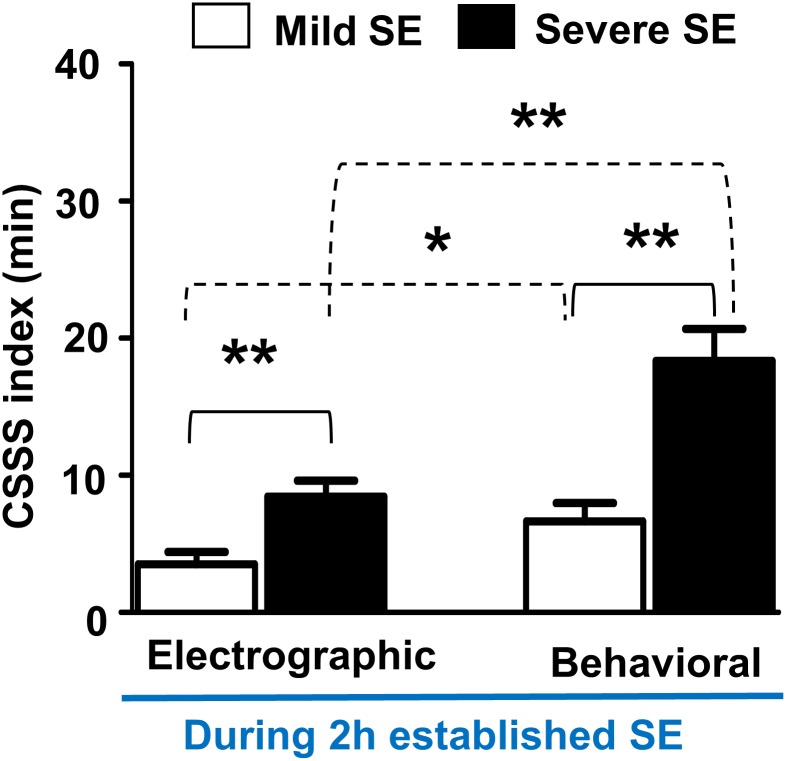
Behavioral and electrographic CSSS indices comparison between the severe and the mild SE groups during the 2 hours established SE.The CSSS indices for both behavioral and electrographic seizures were significantly higher in the severe SE group, when compared to the mild SE group (**p = 0.0047, electrographic CSSS; **p = 0.0011, behavioral CSSS; n = 9, Mann-Whitney test). There was almost 50% difference between the electrographic and the behavioral CSSS indices in both groups (*p = 0.037 for the mild group, **p = 0.0023 for the severe group, Mann-Whitney test).